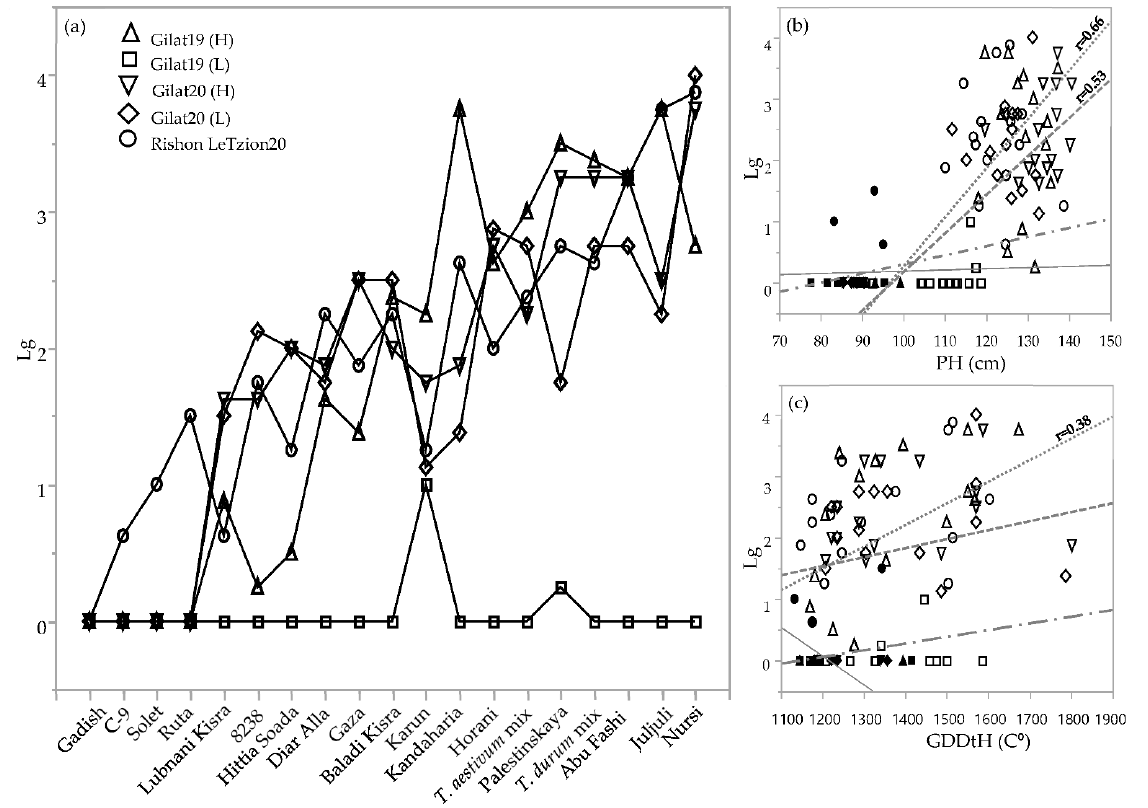
Figure 4. Lodging rate of the IPLR subset panel. Lodging score (from 0 = no lodging to 5 = complete lodging) across 5 environments during 2018–2019 and 2019–3020 seasons ( a ). Correlations between lodging, plant height ( b ), and growing degree days to heading ( c ) of 19 genotypes in 5 different environments. Modern cultivars (solid symbols); landraces (hollow symbols); durum landraces (dotted line); bread wheat landraces (dashed line); durum modern cultivars (continuous line); bread wheat modern cultivars (dotted dashed line). Slopes values are presented only where the linear model was significant ( p < 0.05).